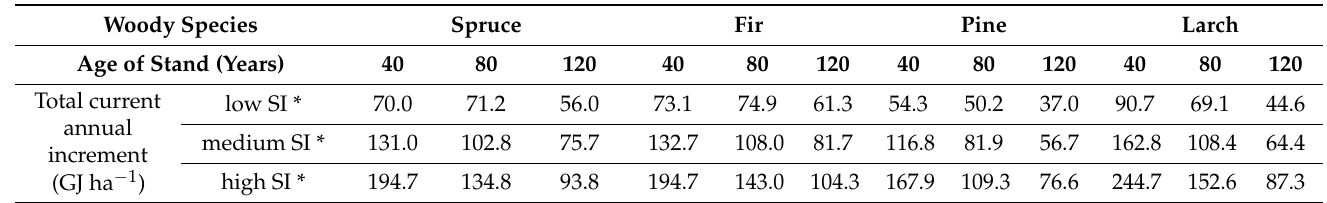
Table 4. The development of energy reserves in the total current annual increments of stands with low, medium and high site index.